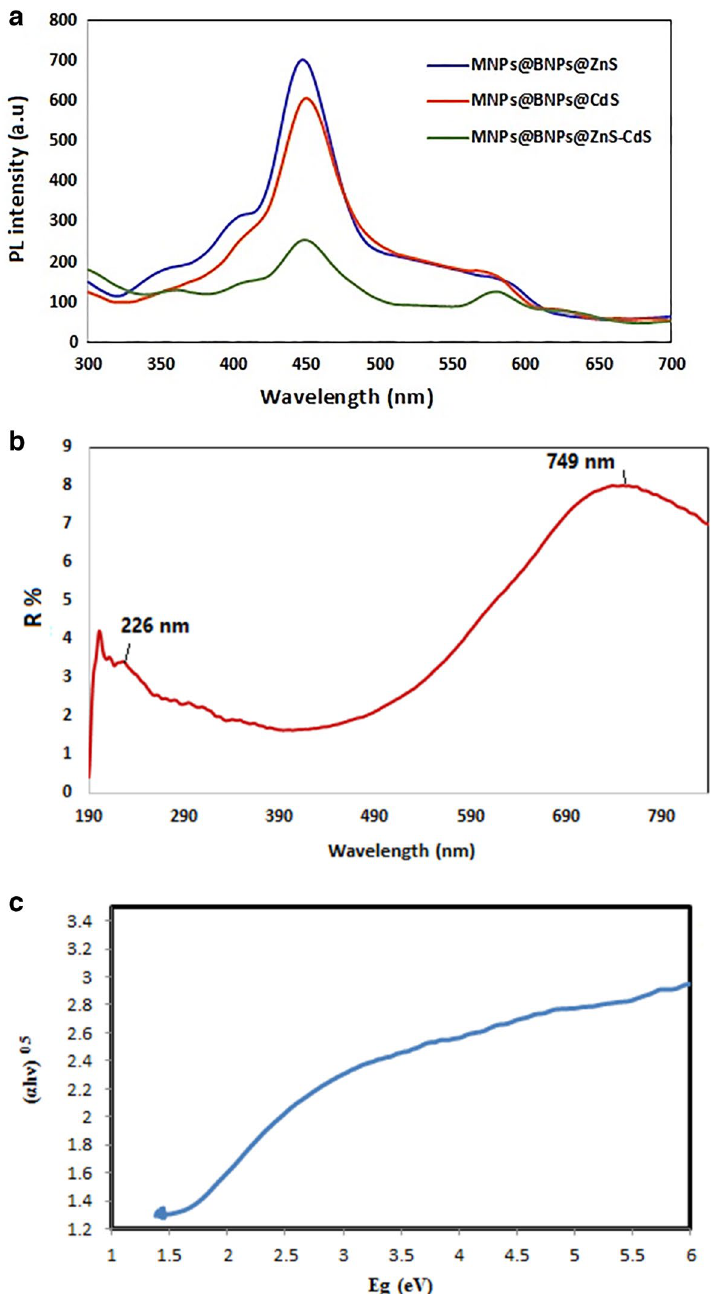
Figure 5. ( a ) PL spectra of Fe 3 O 4 @BNPs@ZnS-CdS, Fe 3 O 4 @BNPs@ ZnS and Fe 3 O 4 @BNPs@CdS ( b ) DRS spectrum of nanocomposite and ( c ) Tauc plots of the Fe 3 O 4